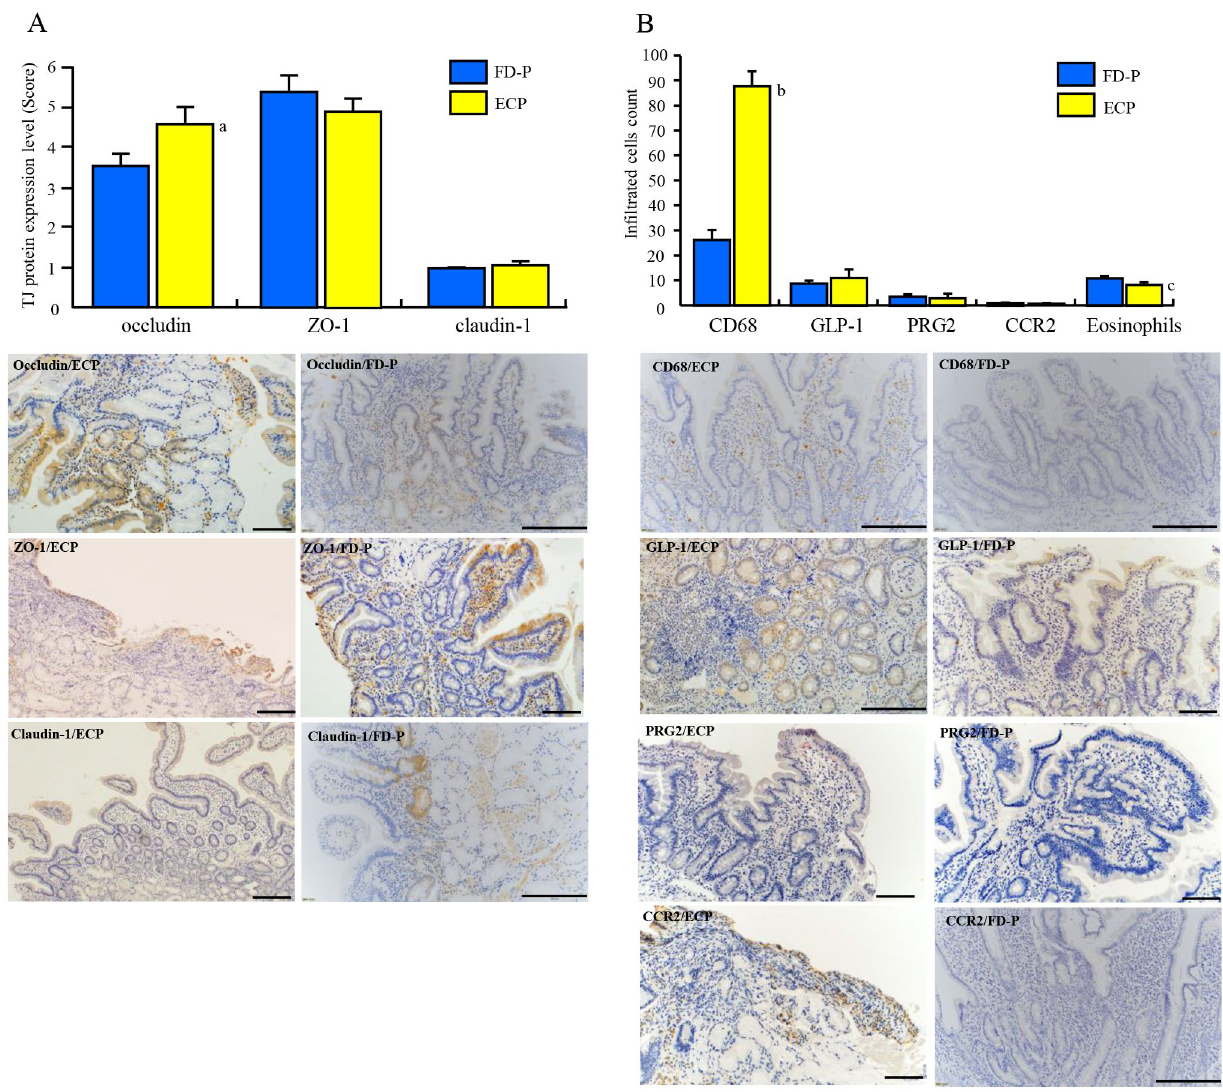
Fig 3. Comparison of the expression levels of tight junction (TJ) proteins such as occludin, ZO-1 and claudin-1 between ECP and FD-P patients. 3A. The expression levels of occludin were significantly higher in ECP patients than those patients with FD-P. In addition, there were not significant differences in ZO-1 and claudin-1 expression levels between ECP and FD-P patients. Representative occludin, ZO-1, and claudin-1 positive cells can be seen in patients with FD-P and ECP. a. vs FD-P patients, p = 0.048. 3B. Comparison of the expression levels of eosinophils, CD68-, GLP-1-, PRG2- and CCR2-positive cells between ECP and FD-P patients. CD68-positive cells were significantly (p < 0.01) higher in ECP patients than that of FD-P patients. Eosinophils were significantly (p = 0.008) higher in patients with FD-P than those of patients with ECP. However, there were not significant differences in GLP-1-positive cells, PRG2-positive cells and CCR2-positive cell between ECP and FD-P patients. Representative CD68-, GLP-1-, and CCR2-positive cells can be seen in patients with FD-P and ECP. b. vs FD-P patients, p < 0.01. c. vs FD-P patients, p = 0.008. These groups were compared using two-tailed, unpaired,